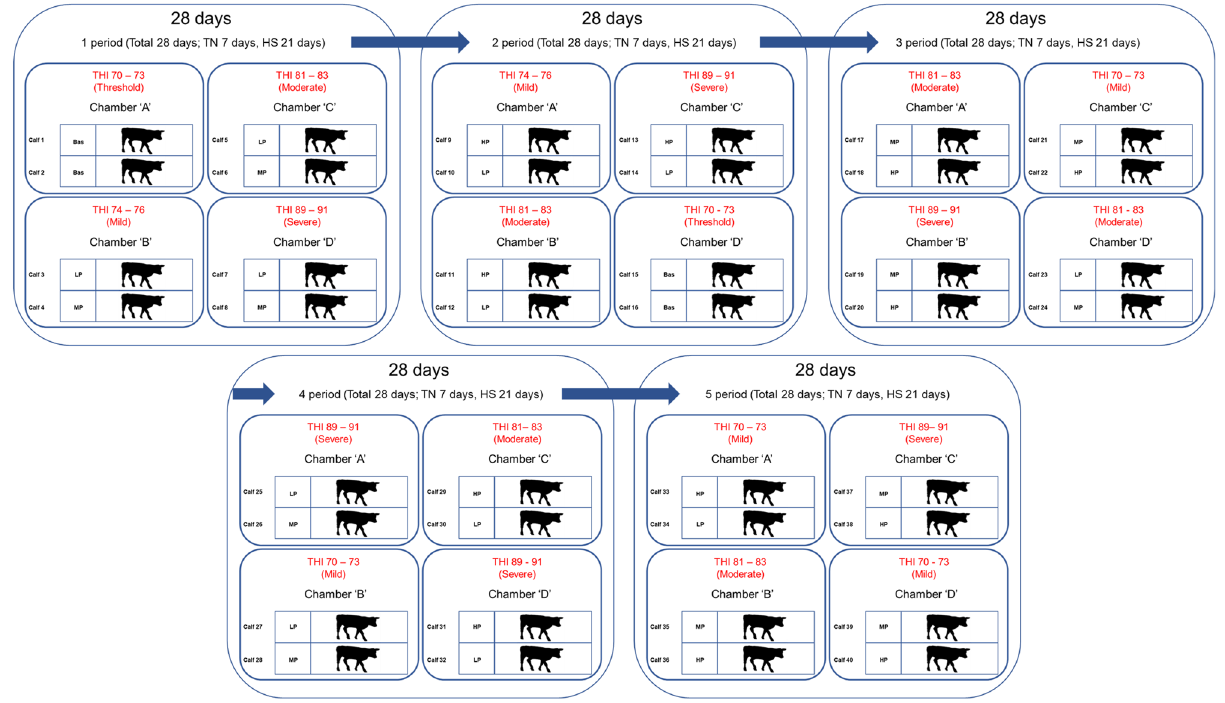
Figure 1. Experiment design. In our study the forty calves were divided to 8 calves per period (total five periods) to assign to one of the four chambers (two calves per chamber) with the respective protein treatment being assigned to the calves in the climatic chamber containing tie-stall